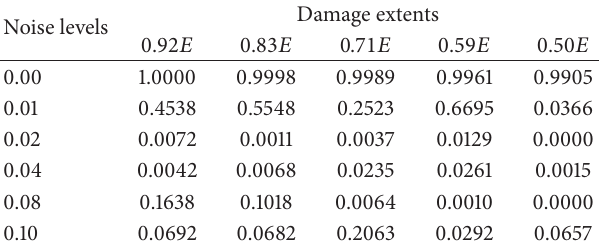
Table 6: The MAC values of stain damage parameter vector extracted from the same load case.